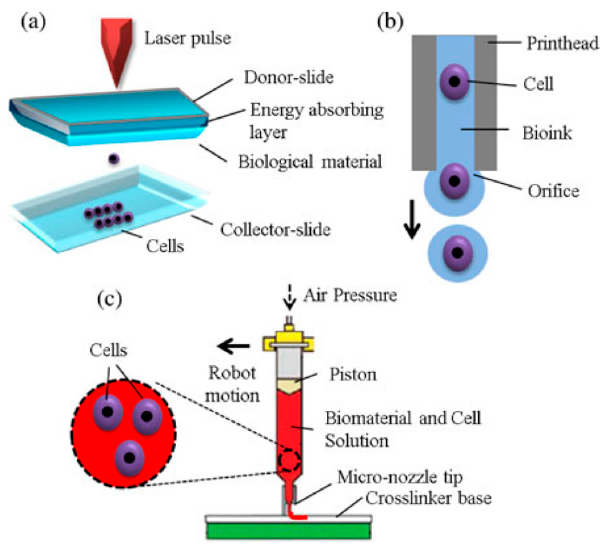
Figure 2. Working principles of three main groups of bioprinting technologies for tissue and organ engineering: ( a ) laser-based bioprinting; ( b ) inkjet-based bioprinting; and ( c ) extrusion-based